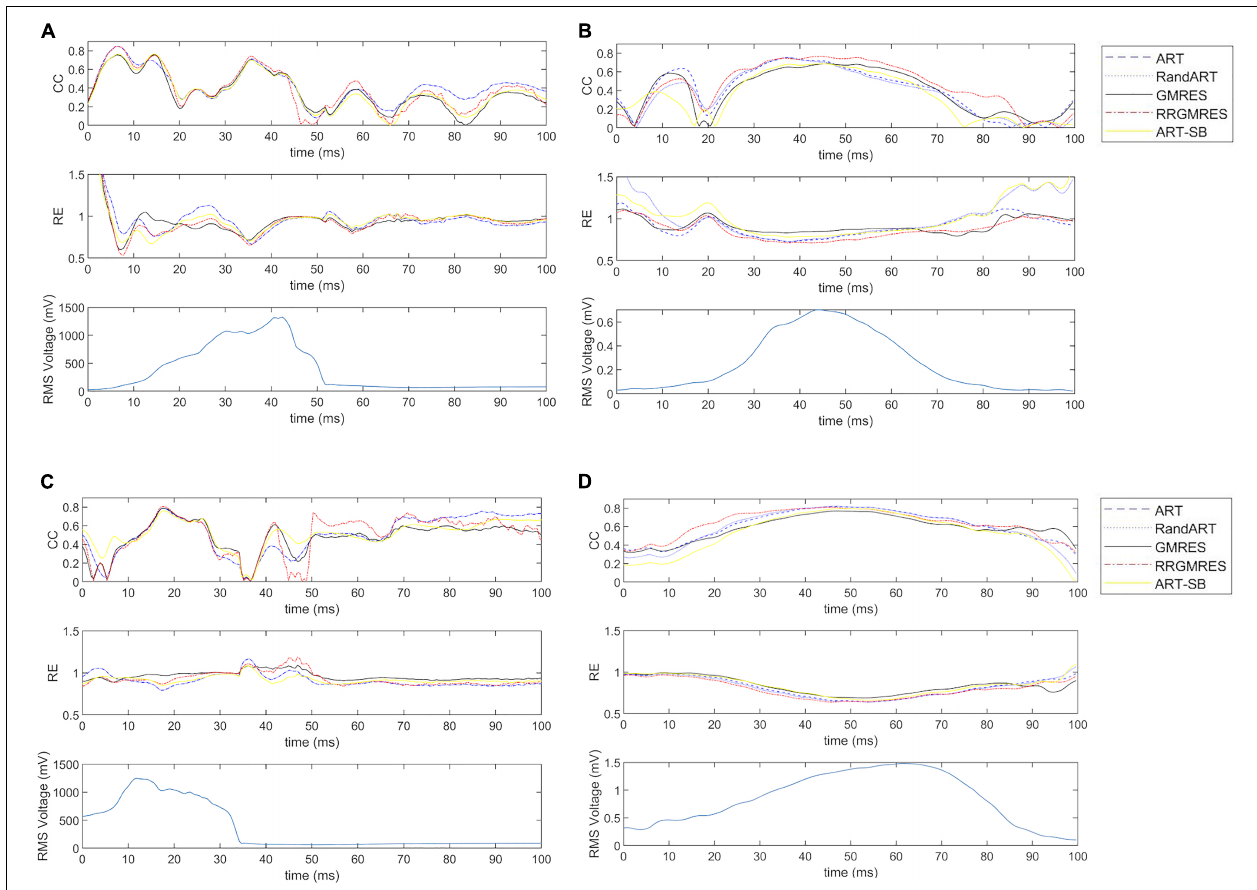
FIGURE 6 | For the datasets: (A) the sinus rhythm of Maastricth; (B) the sinus rhythm of Auckland; (C) the paced rhythm of Maastricth; (D) the paced rhythm of Auckland. From top to down: “temporal” CC and RE of each reconstruction technique and RMS of the target potentials. All of them for a defined 100 ms window over the QRS.